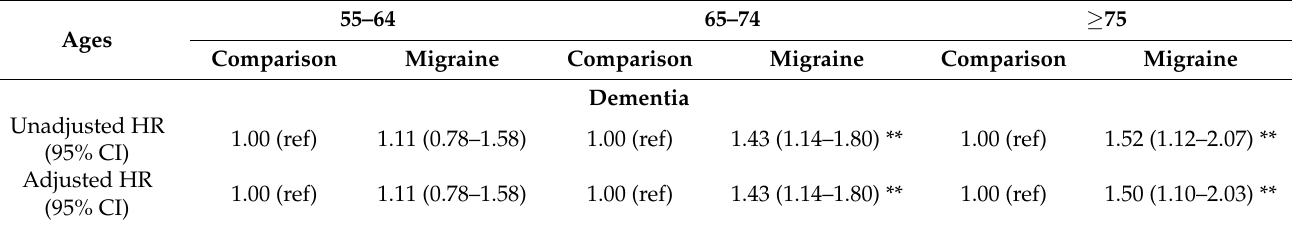
Table 5. Hazard ratios of dementia by age among the sample patient.